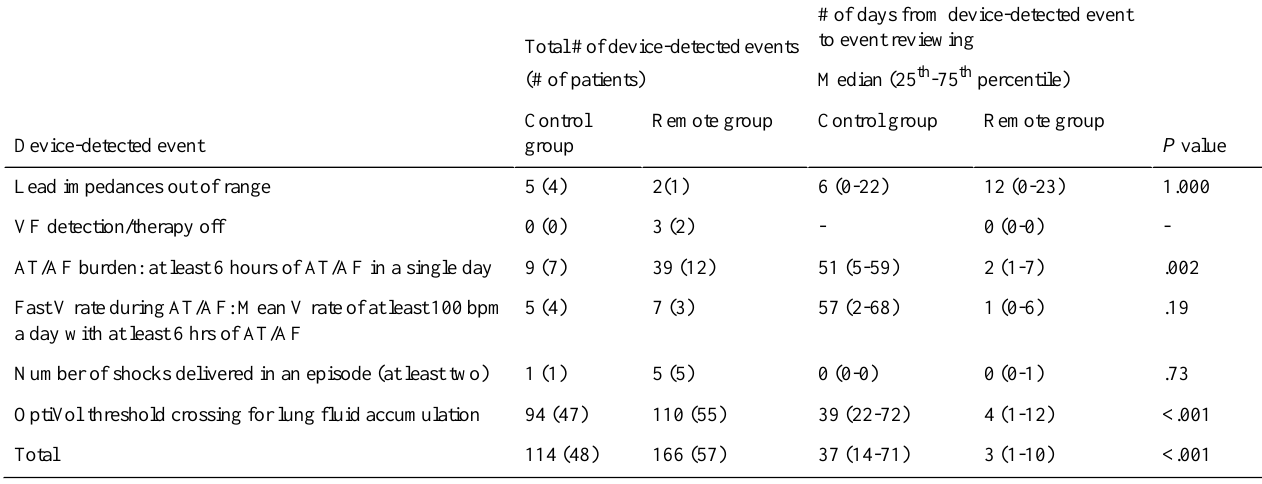
Table 2. Device-detected events—delays from a device-detected event to review of the alert (including alerts with unsuccessful transmissions in the Remote group, which were evaluated during an in-office